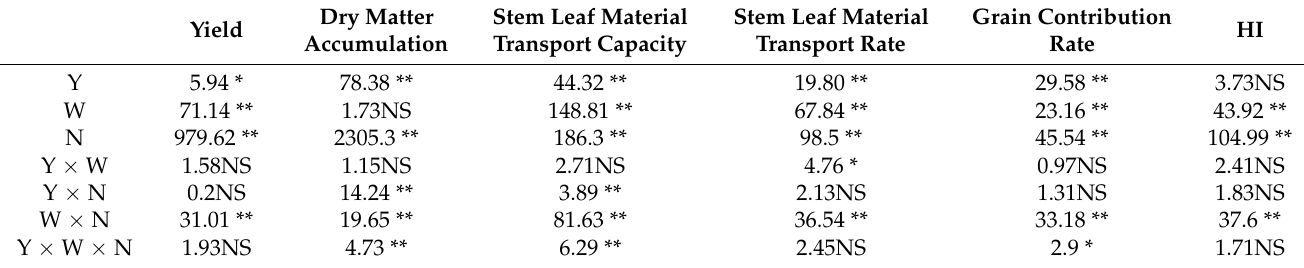
Table 5. Interaction effects of water and nitrogen on the rice HI and its related